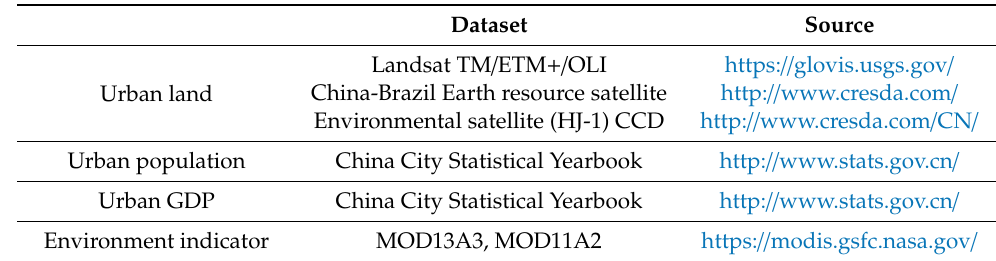
Table 2. Information of the datasets.